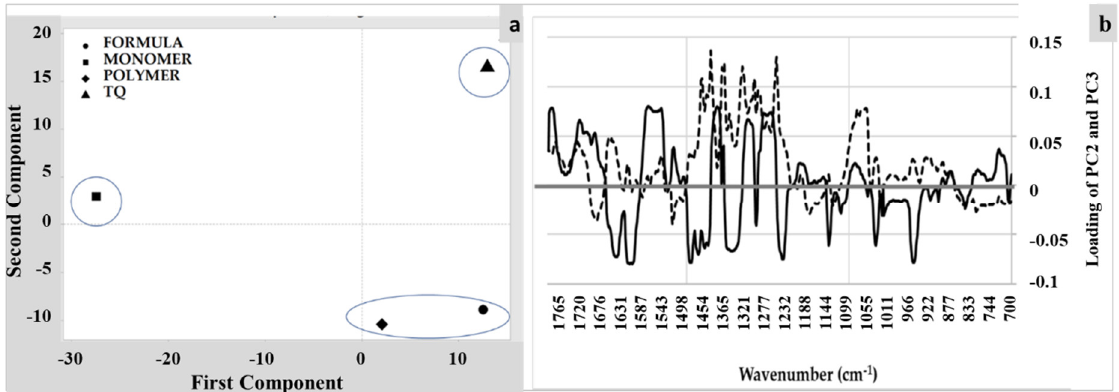
Figure 4. PCA of FTIR spectra (1800–700 cm −1 ) of TQ, the monomer, the polymer, and TQ-loaded polymer (formula): ( a ) score plot of PC1 (86.2%) vs. PC2 (7.5%) and ( b ) loading profiles of PC2 and PC3 within the allocated range (the dotted line is the loading profile of PC3, while the solid black line represents the loading profile of PC2).